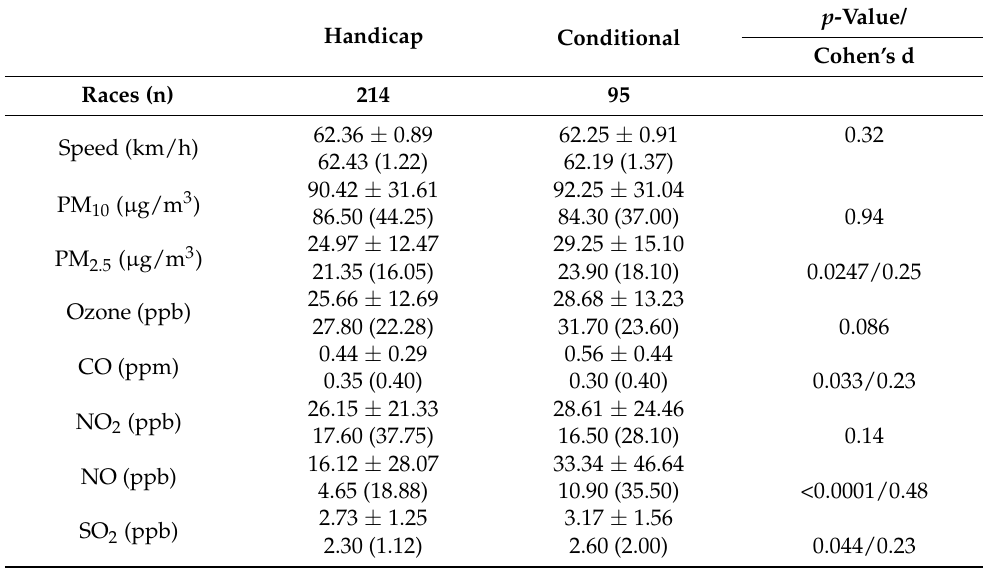
Figure 2. Data analysis inclusion and exclusion criteria. First, a “Classic” type race with a “heavy” or “regular” track was excluded. Then, those that included more than one curve were excluded by track design. Finally, statistical analysis was performed in the 1000, 1100 and 1200 m races comparing the “Handicap” races with the “Conditional” races. Table 1. Comparison between the race speed and pollutant concentration of all races in the “Handicap” versus “Conditional” groups. The p value shown corresponds to the t-student or Mann-Whitney test, according to the distribution of the data, in addition to Cohen’s “d”, calculated when there were differences. Values are expressed as mean ± standard deviation and median (IQR).